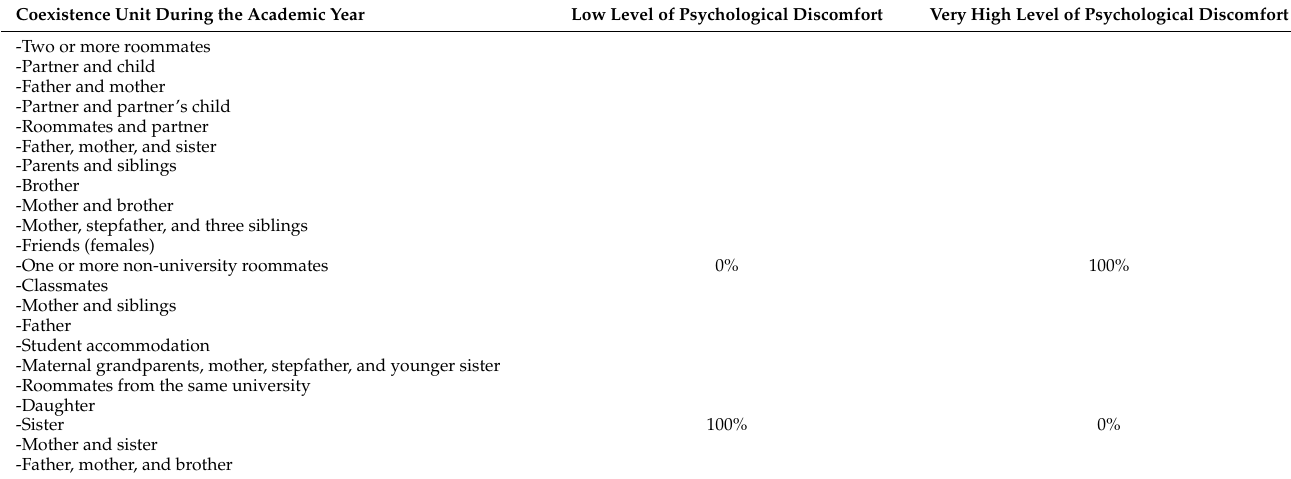
Table 1. Percentages of affectation in coexistence units in low and high levels of psychological discomfort.